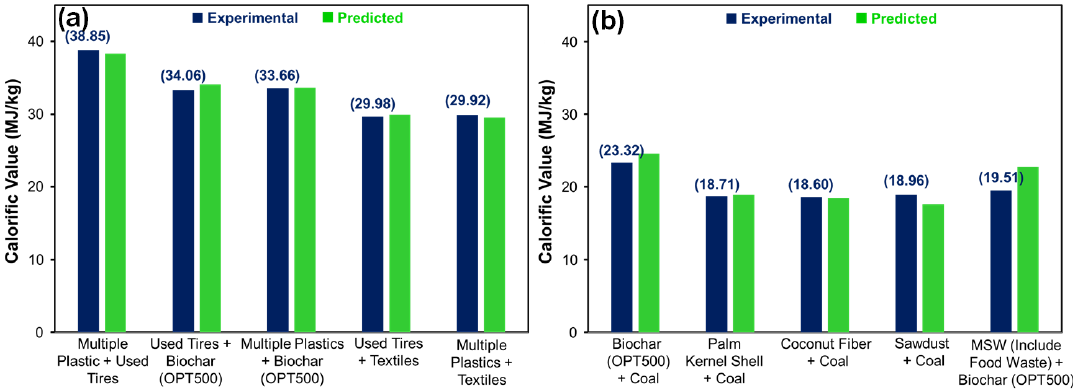
Fig. 2. Summary of the optimized combination sample data used to validate (a) Correlation A for MSW and (b) Correlation D for biomass/biochar mixture.